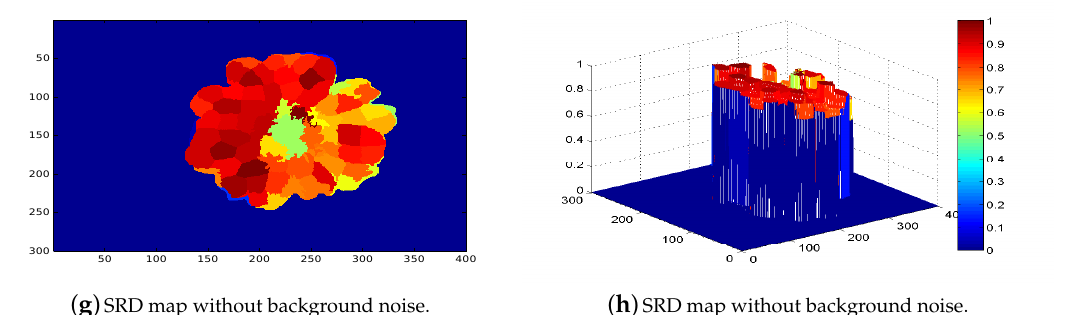
Figure 3. The effectiveness of the heuristic background dictionary for highly precise and exact salient object maps